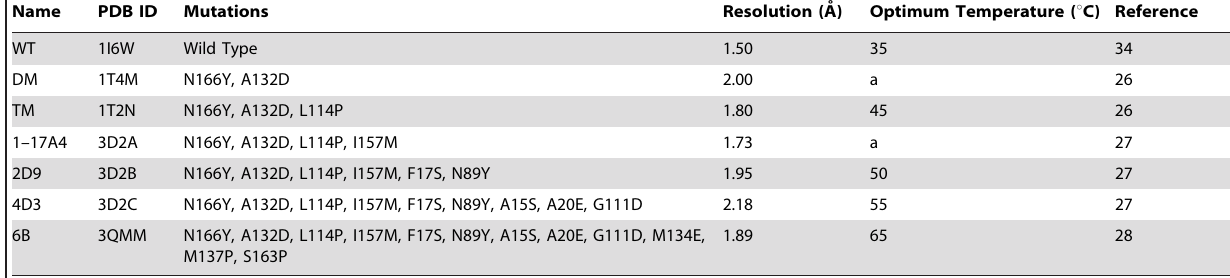
Table 1. Structures used for the analysis.